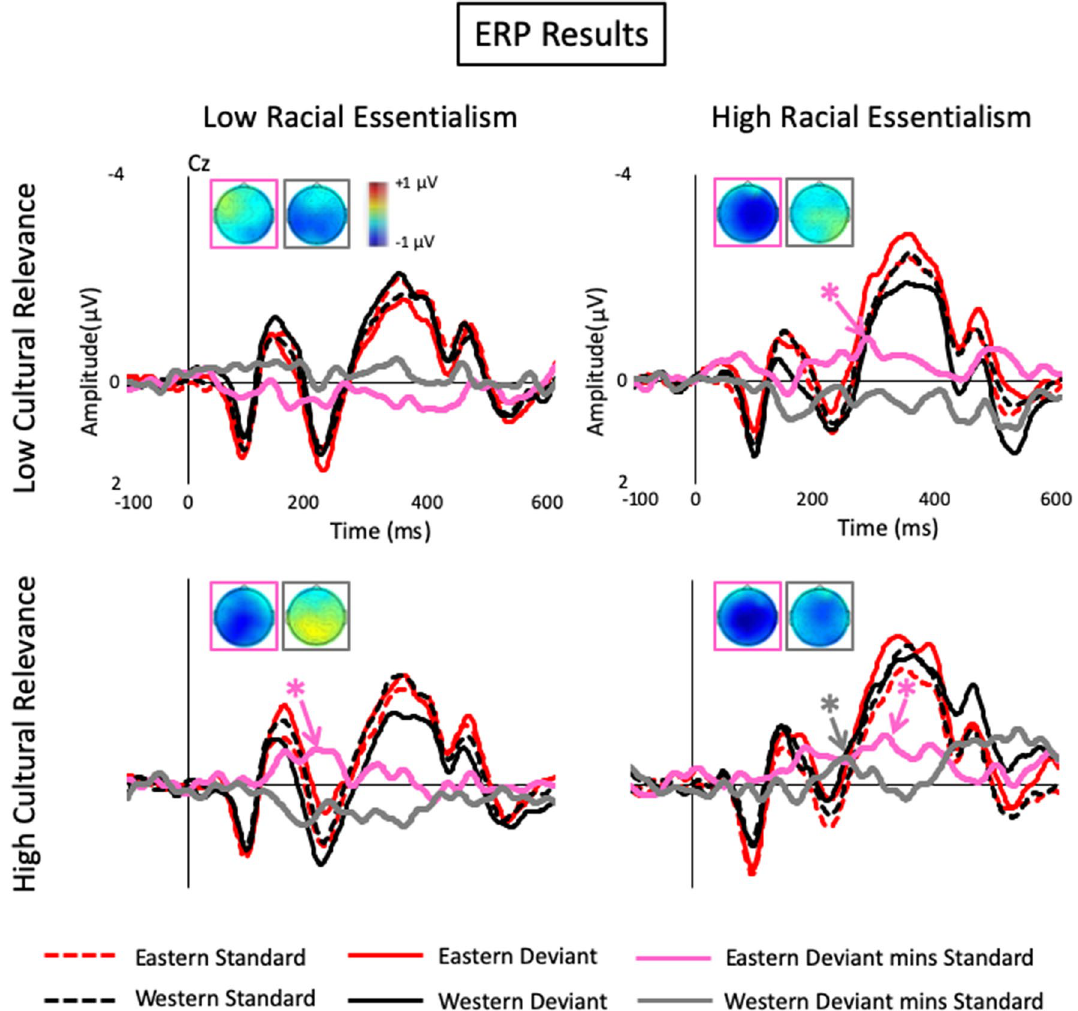
Figure 2. ERP waveforms to the standard and deviant cultural pictures and the deviant-minus-standard difference waveforms at the Cz electrode time-locked to the onset of stimuli. The scalp maps show a central distribution at the 40 ms time period of the peak vMMN responses. For individuals with high racial essentialism, vMMNs were elicited by both the Eastern and Western deviants with high cultural relevance, but only by the Eastern deviants with low cultural relevance. For individuals with low racial essentialism, vMMN was only elicited by the Eastern deviants with high cultural relevance. Positive ERP responses are plotted downward and represented by hot colors in the scalp maps. * indicates significant peak vMMN response ( p < 0.05) in the 150 ms to 400 ms analysis time high racial essentialism group showed larger vMMNs to cultural changes than the low racial essentialism group (Fig. 3). Specifically, for the high racial essentialism group, the vMMNs elicited by the Eastern deviants with high cultural relevance ( t (19) = − 2.37, p = 0.014, Cohen ʼ s d (d) = − 0.53 and the Eastern deviants with low cultural relevance ( t (19) = − 2.47, p = 0.012, d = − 0.55) were statistically significant. The vMMN to the Western deviant with high cultural relevance ( t (19) = − 1.98, p = 0.031, d = − 0.44) was significant, but not to the Western deviant with low cultural relevance ( t (19) = 0.12, p = 0.55, d = 0.028). For the low racial essentialism group, vMMN was only observed to the Eastern deviant with high cultural relevance ( t (19) = − 3.67, p < 0.001, d = − 0.82), but not to the Eastern deviant with high cultural relevance, or the Western deviants with high or low cultural relevance ( ts (19) = − 1.02 to 1.55, ps = 0.16 to 0.48, ds = 0.018 to − 0.23). The effect sizes of the vMMNs ranged from − 0.44 to − 0.82, which were similar to the vMMNs that were calculated with properly controlled standards or control stimuli and elicited by abstract deviants 18,37,45 . A larger MMN effect size could be observed if the MMN was contaminated by the brain responses to the physical differences between the deviant and standard and/or the adaptation confound. The mixed-effect ANOVA showed a main effect of culture type ( F (1, 38) = 4.71, p = 0.036, η 2 p = 0.11), while the main effects of cultural relevance and racial essentialism were not significant ( F s(1,38) = 0.32 and 2.71, p s = 0.58 and 0.11, η 2 p s = 0.008 and 0.067). The two-way interaction effects between racial essentialism and culture type ( F (1,38) = 0.32, p = 0.58, η 2 p = 0.008), between racial essentialism and cultural relevance ( F (1,38) = 0.54, p = 0.47,